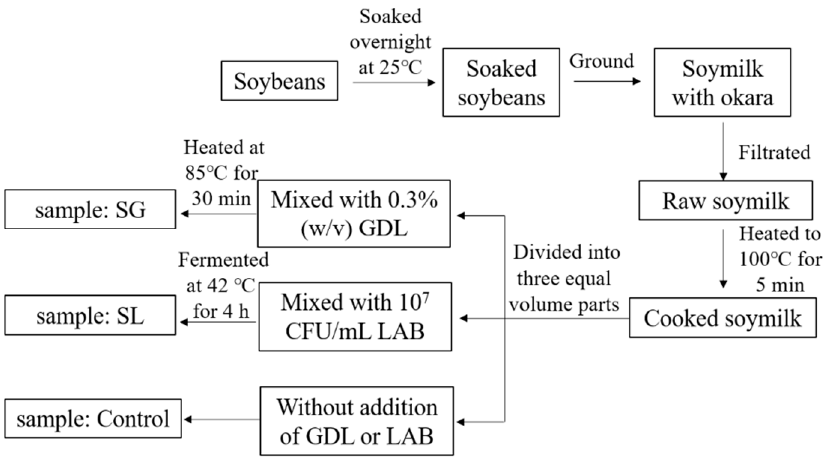
Figure 5. Schematic diagram of the step-by-step preparation of soymilk gels.